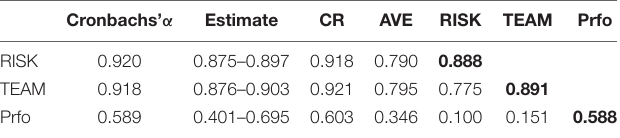
TABLE 3 | Factor load and reliability and validity